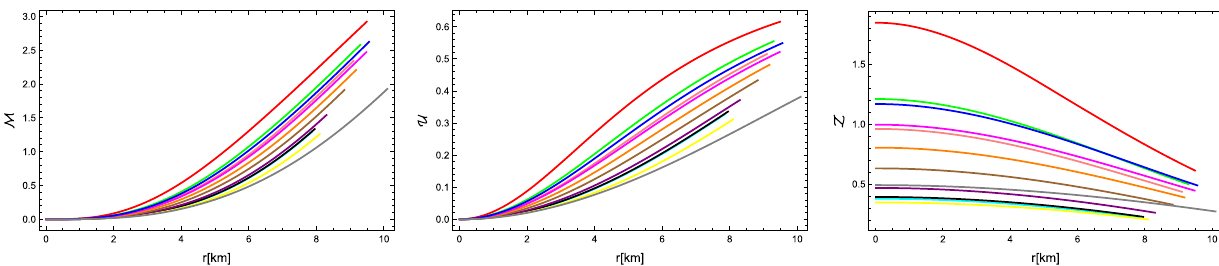
Fig. 9 Graphs of mass function (left panel), compactness factor (middle panel), and redshift(right panel) of S 1 ( (cid:2) ), S 2 ( (cid:2) ), S 3 ( (cid:2) ), S 4 ( (cid:2) ), S 5 ( (cid:2) ), S 6 ( (cid:2) ), S 7 ( (cid:2) ), S 8 ( (cid:2) ), S 9 ( (cid:2) ), S 10 ( (cid:2) ), S 11 ( (cid:2) ), S 12 ( (cid:2) )